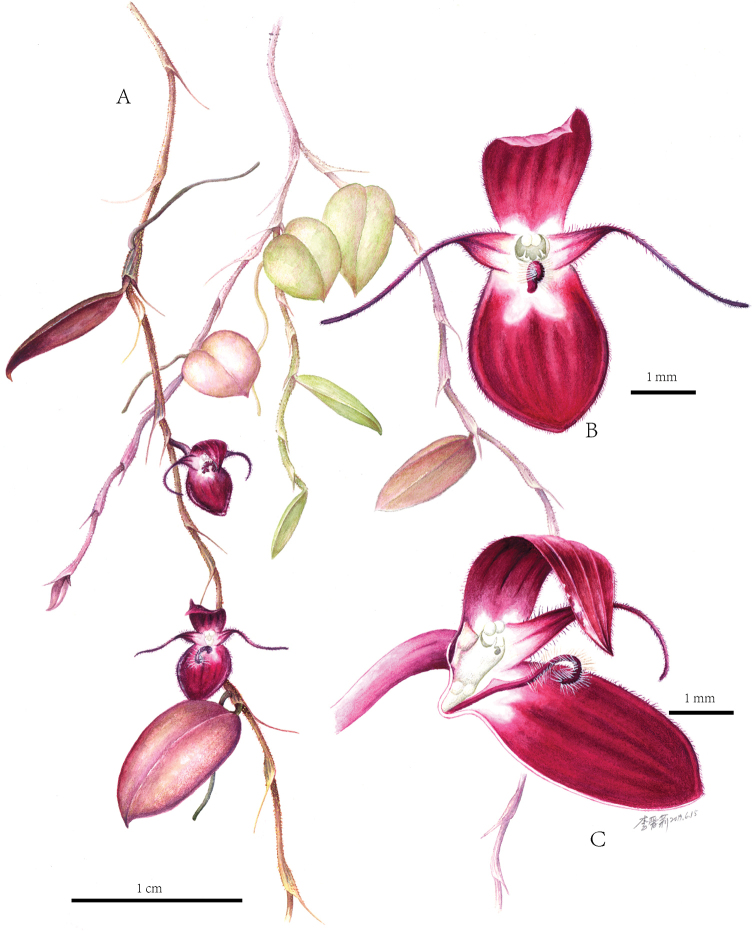
Color drawing of Bulbophyllum
papuaenseA Plants B front view of flower C lateral view of flower.